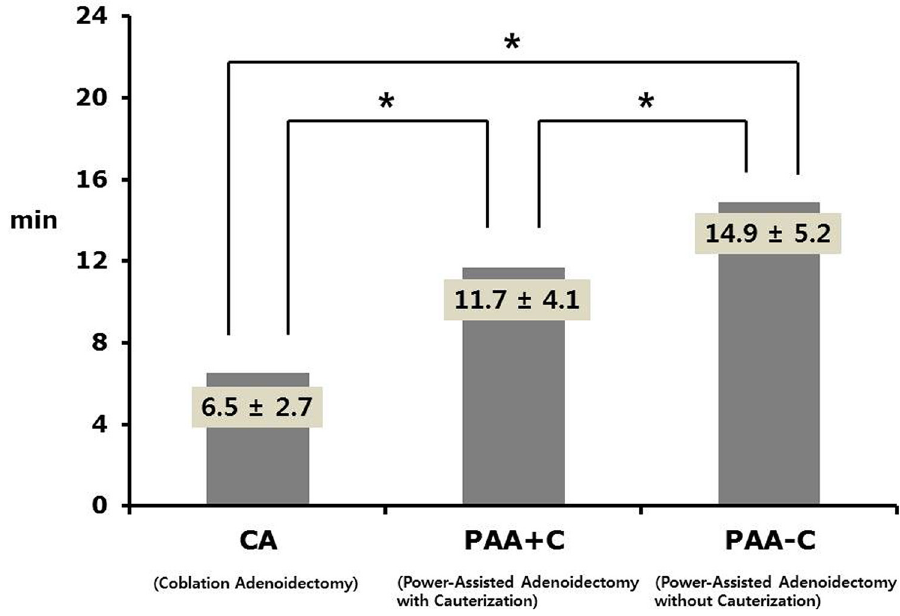
Fig 1. Comparison of mean operation time among CA, PAA+C, and PAA-C groups (N = 388).